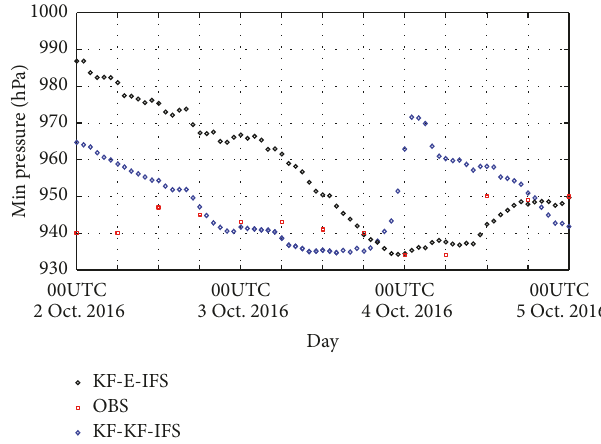
Figure 9: Comparison between the observed Matthew minimum pressure (2 October–5 October 2016, 6-hourly step) and the pre- dicted ones by KF-E-IFS and KF-KF-IFS WRF simulations (at 5 km, hourly